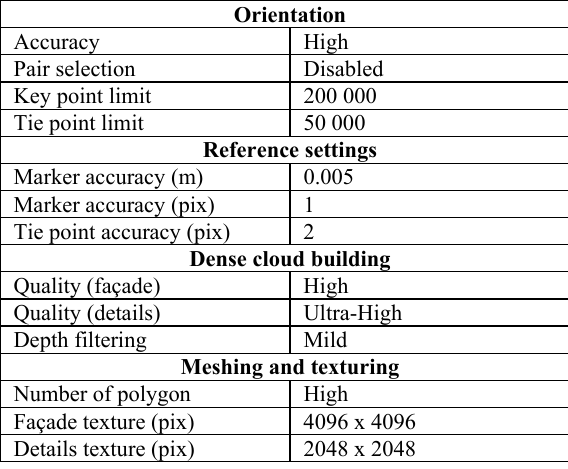
Table 4. Computation parameters used in